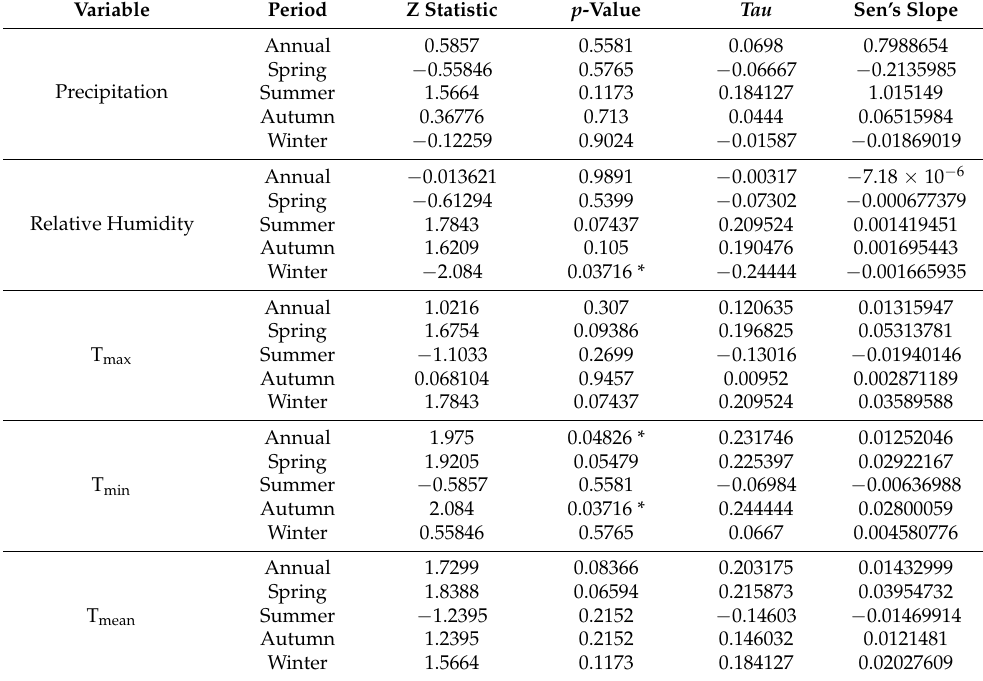
Table 8. MK test results for TT Singh for the period